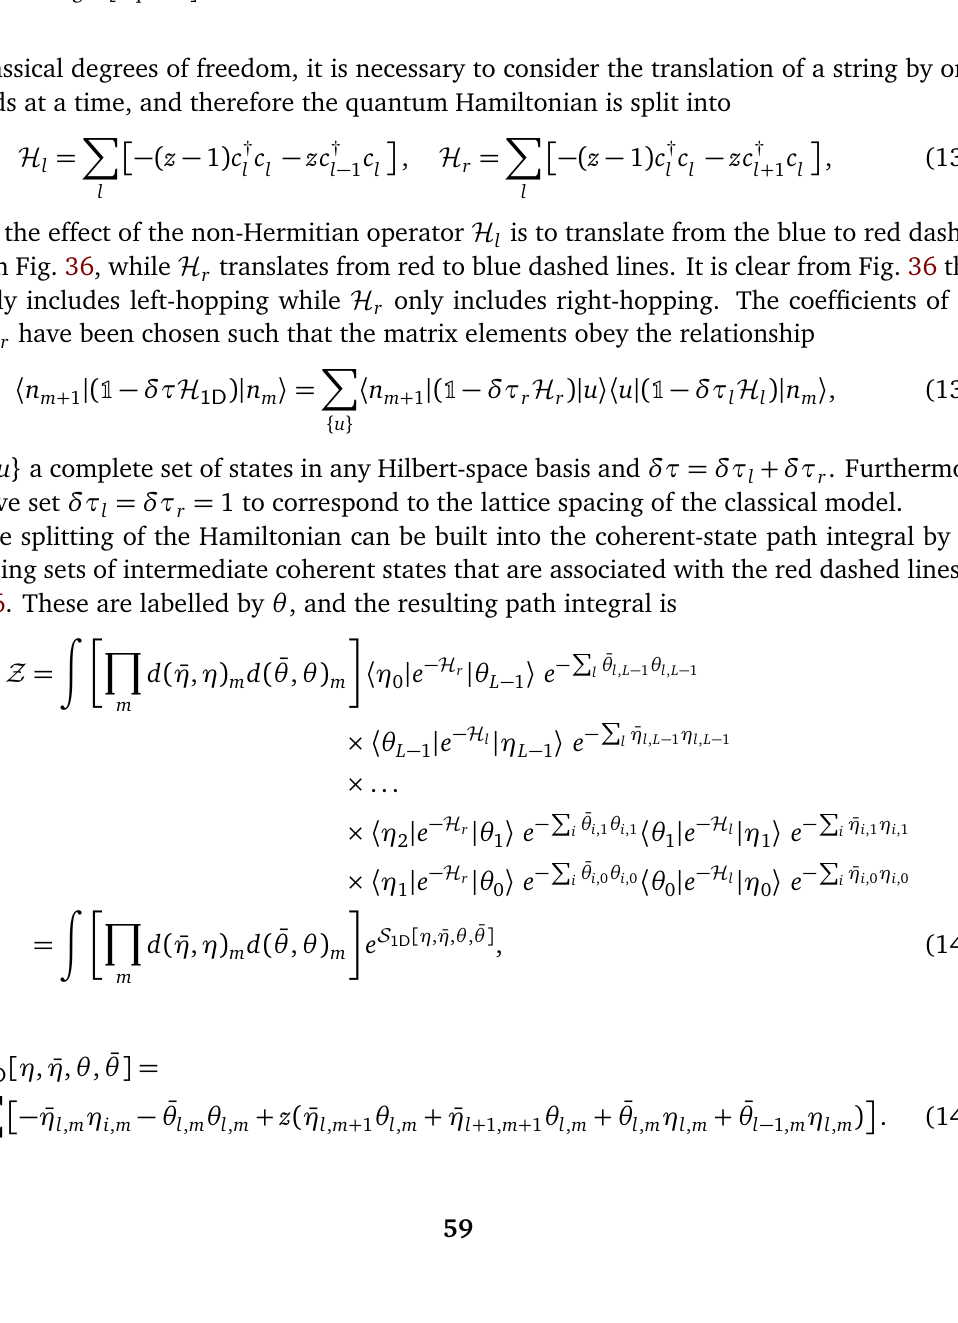
and H , describing hopping to the l r